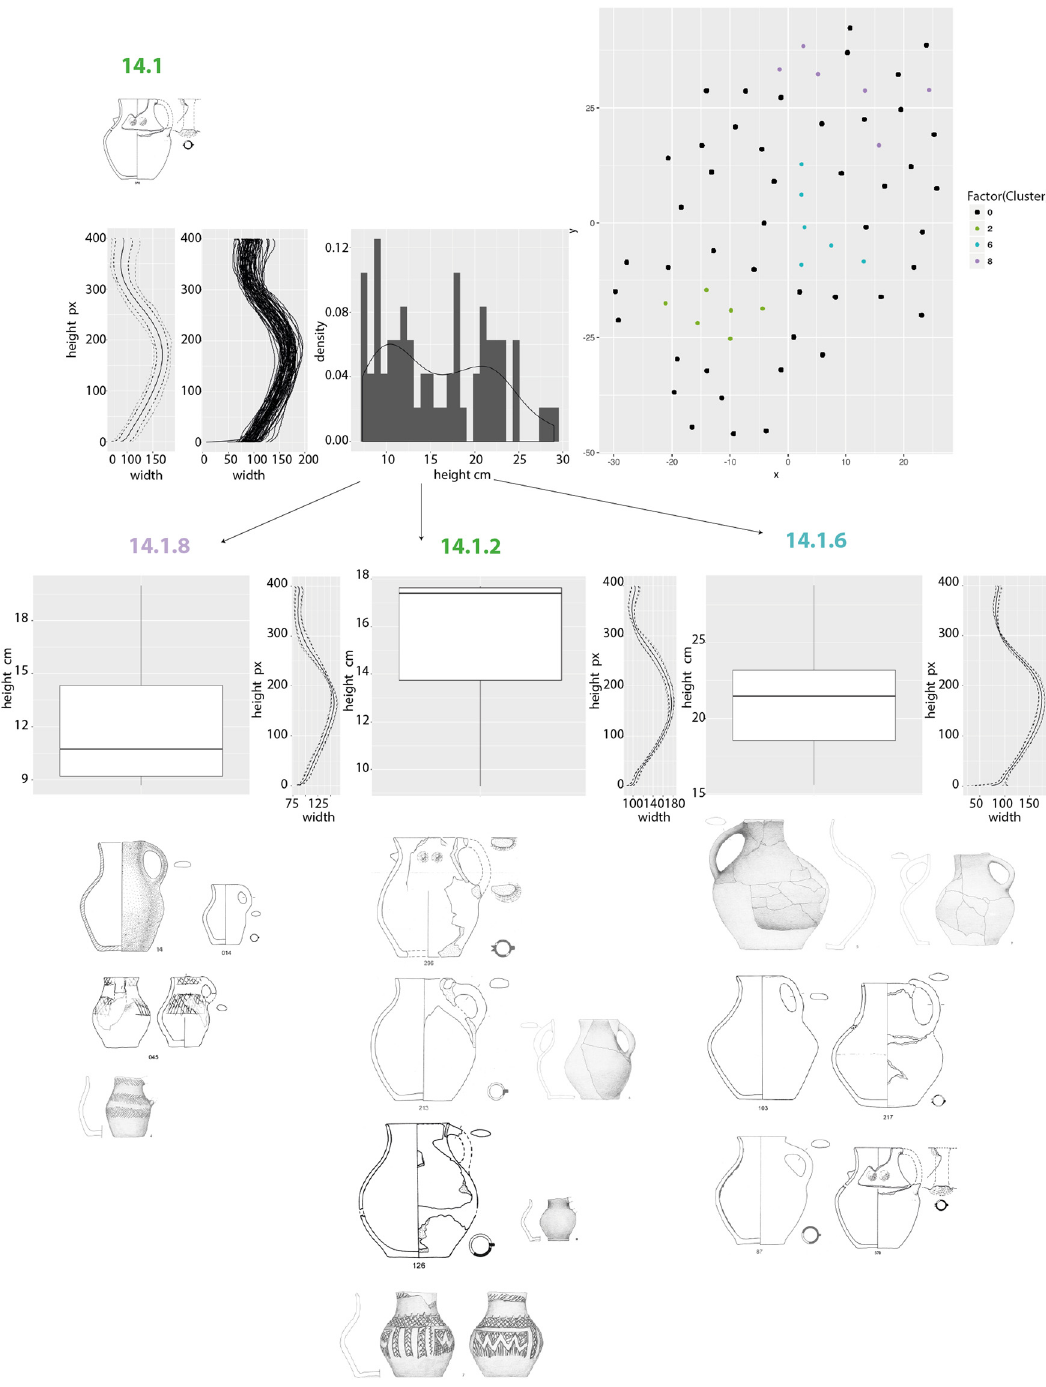
Figure 9: Subcluster 14.1, 14.1.8, 14.1.2, and 14.1.6 on the third hierarchical level ( fi gure: M. Hinz and C. Heitz, for the picture credits of the pottery drawings, see doi: 10.5281/zenodo.7258694 )